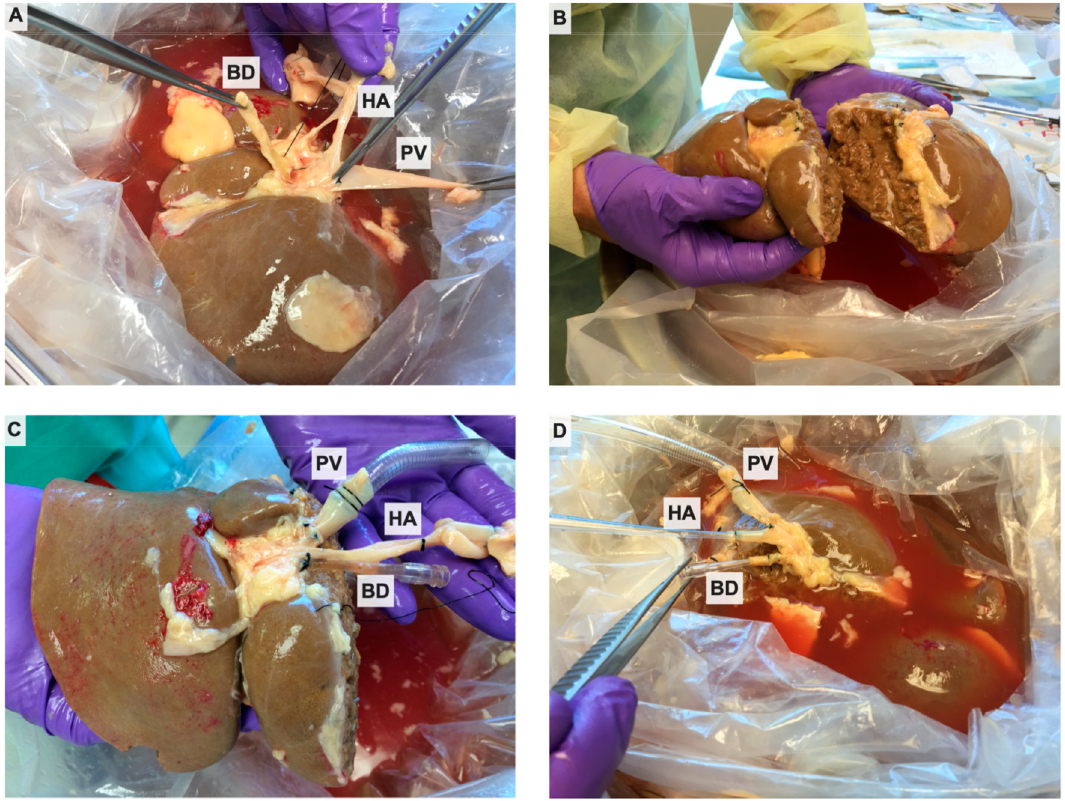
Figure 1. Splitting of discarded donor liver. ( A ) The whole graft is thoroughly explored, and dissection is performed to the level of the bifurcation of the hepatic artery (HA), portal vein (PV), and bile duct (BD). ( B ) An anatomical split is performed, with assurance of adequate inflow and outflow. ( C ) The right lobar and ( D ) left lobar HA, PV, and BD are cannulated.